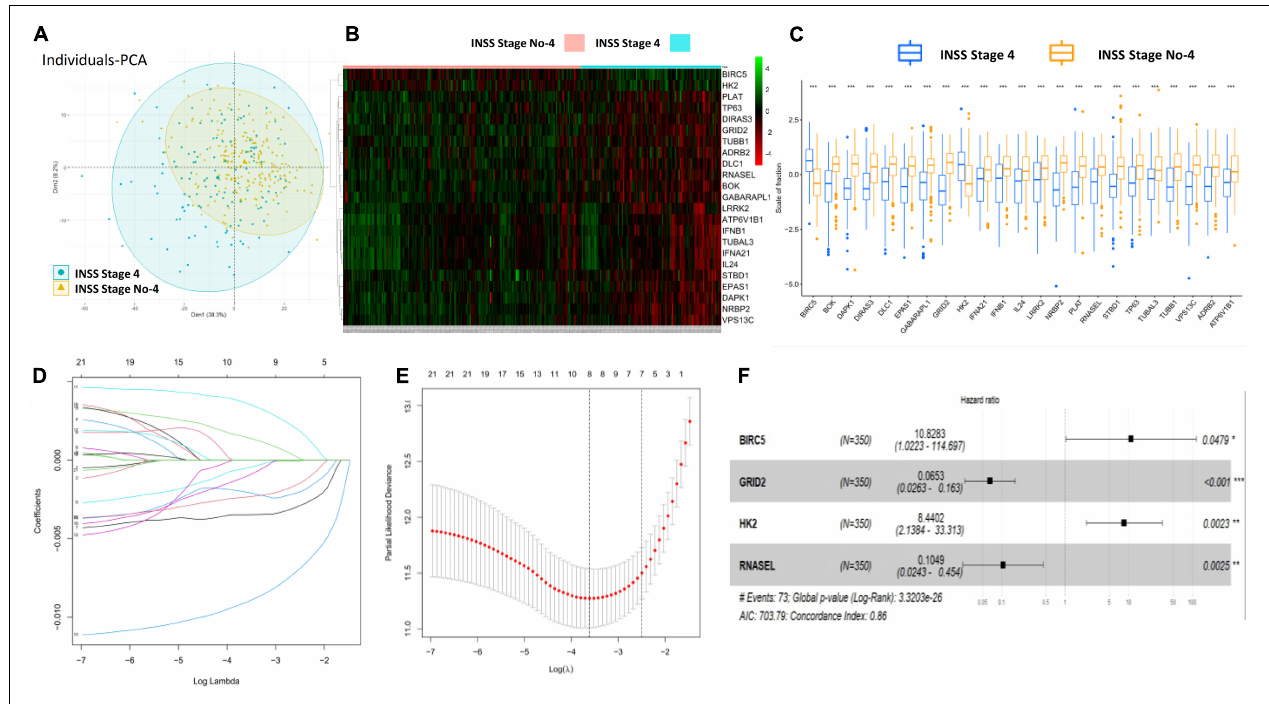
FIGURE 1 | Construction and definition of ATG signature. (A) PCA of ATG mRNAs between INSS stage No-4 and 4. (B,C) Twenty-three DEmRNAs were shown with median expression levels. (D,E) Optimized lambda determined in LASSO regression model, with min lambda 0.0270, there were eight indexes selected. (F) Multivariate Cox regression analysis confirmed four potential prognostic ATG DEmRNAs as independent factors.